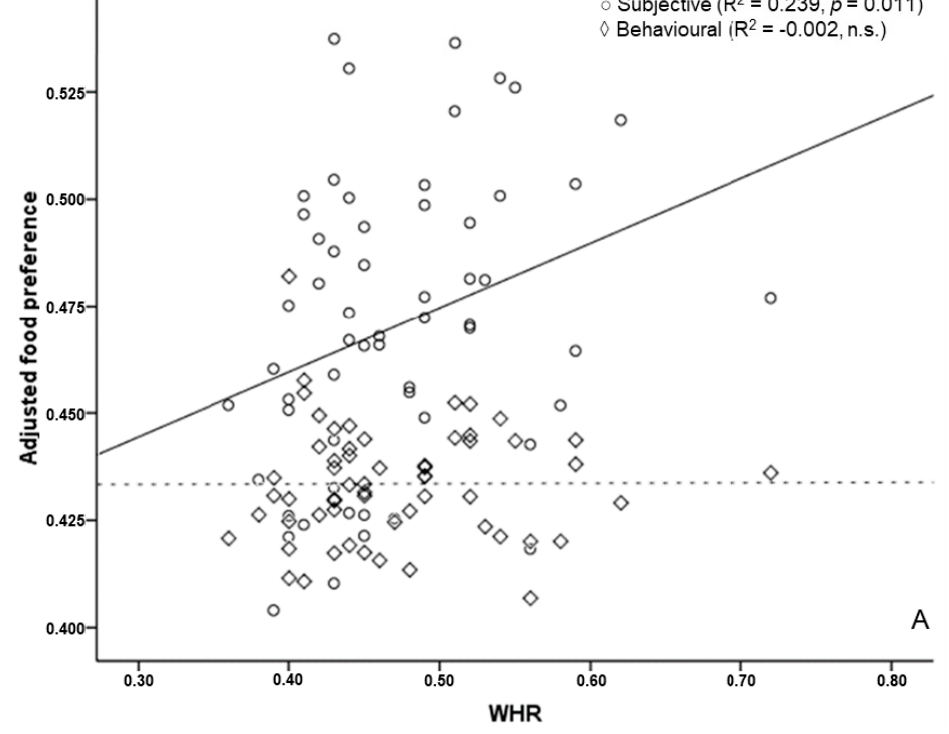
Figure 2. Food preference and anthropometric markers of cardiovascular risk in men and women. Adjusted predicted value of food preference for Waist-to-Hip Ratio ( A ) and Body Adiposity Index ( B ) in total sample. The straight line represents the line of best fit of the subjective category. The dotted line represents the line of best fit of the behavioural category. 3.4. Effect of Time in sAA Levels We performed a regression analysis to examine if the saliva samples were influenced by sAA levels. When the total sample was analysed, no effect was found. This was consistent when we analysed the samples by sex. Given the lack of influence of the moment in which the saliva was collected, further analysis was performed, omitting this variable.